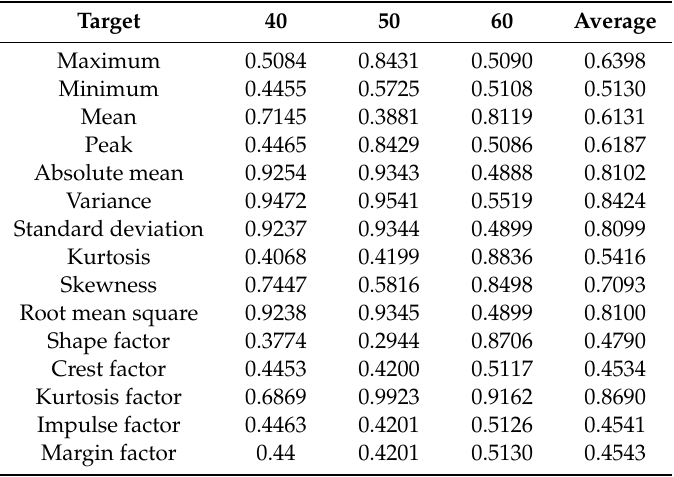
Table 2. Final comprehensive coe ffi